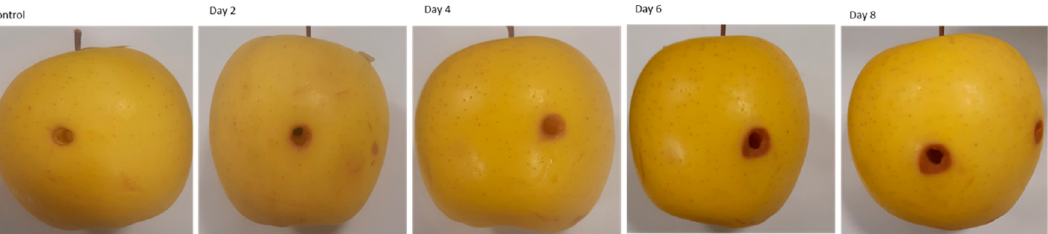
Figure 3. Inoculation of apple fruit with S. liquefaciens . Apple fruits were wounded (depth: 10 mm) on four locations around the equator of each fruit with a sterilized corker borer. The wounds were artificially infected with 100 µ L of bacterial solution (10 6 CFU/mL), whereas control fruits were injected with 100 µ L sterile distilled water. Fruit were incubated in a dark room with a constant high relative humidity of 95% and a temperature of 22 ◦ C. The progression of symptoms was monitored by calculating the average of two perpendicular diameters measured in mm; the rotten areas were 0, 2 ± 0.3, 4 ± 0.5, 7 ± 0.4 and 9 ± 0.2 mm 2, 4, 6 and 8 days after infection,